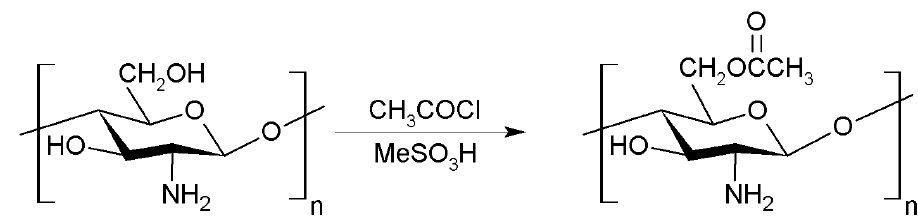
Figure 7. O -acylation of chitosan.